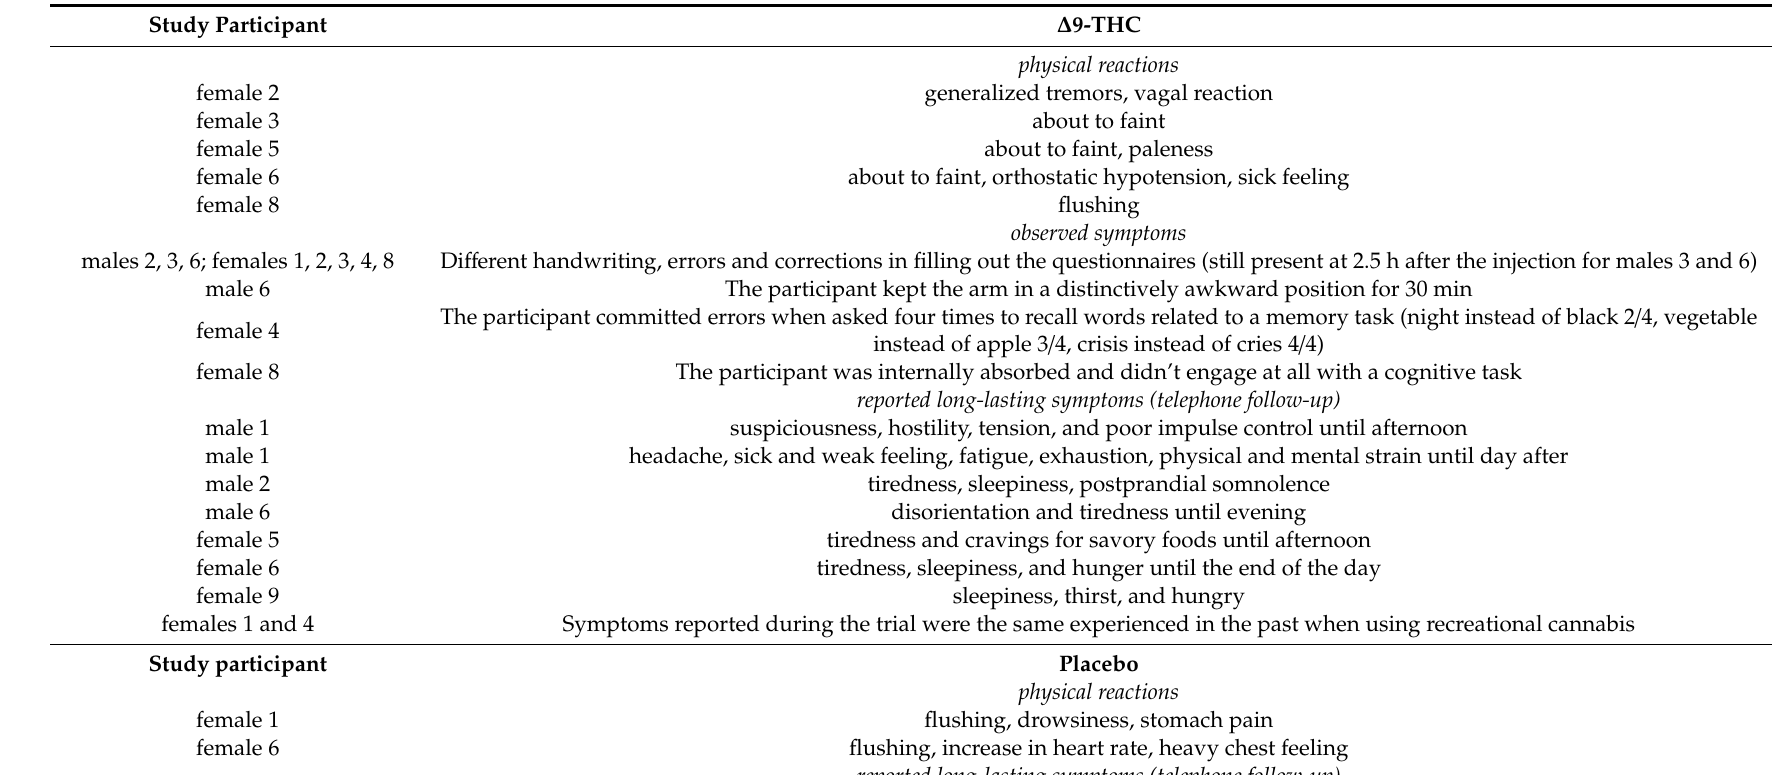
Table 5. Additional